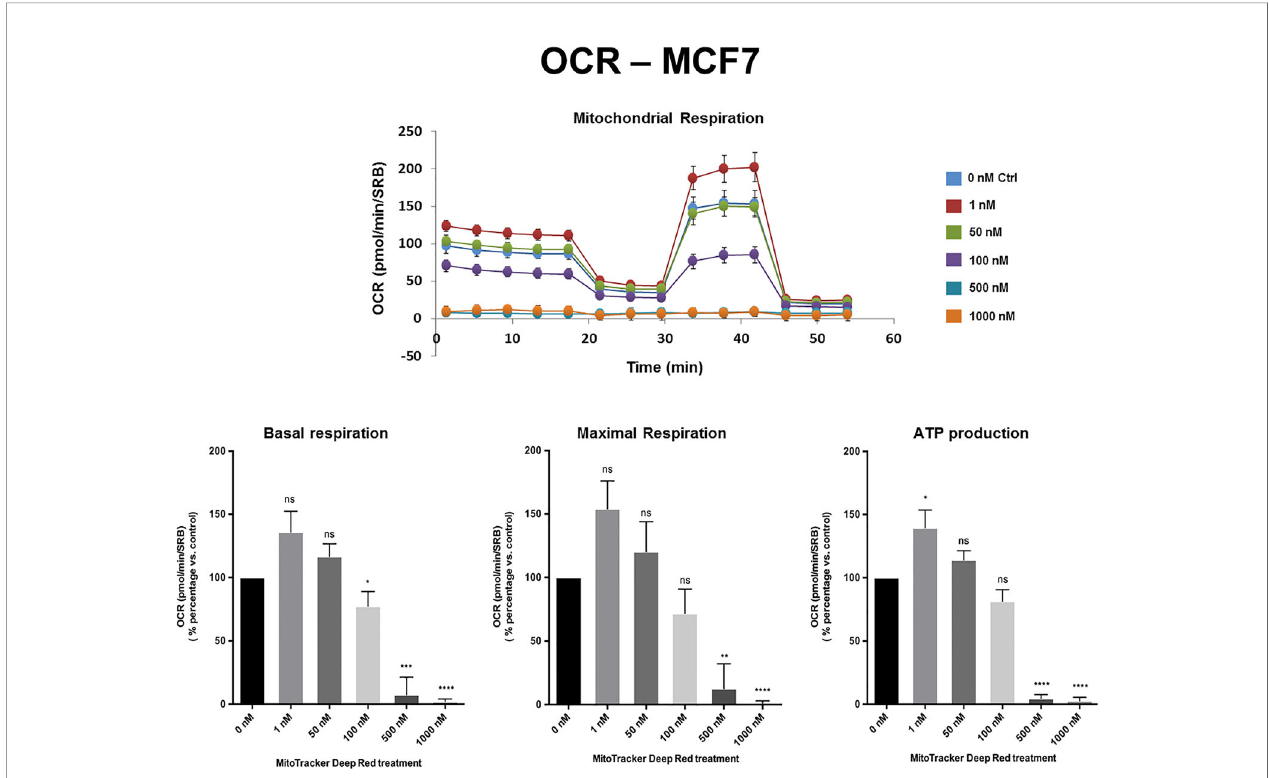
FIGURE 2 | MTDR potently inhibits the mitochondrial oxygen consumption rate (OCR) in MCF7 cells. A representative Seahorse tracing is shown, with bar graphs highlighting the quantitative, dose-dependent effects of MTDR on basal respiration, maximal respiration and ATP production. Note that MTDR treatment exhibits near complete inhibition of OCR in MCF7 cells at 500 nM. The statistical test used was a one-tail unpaired